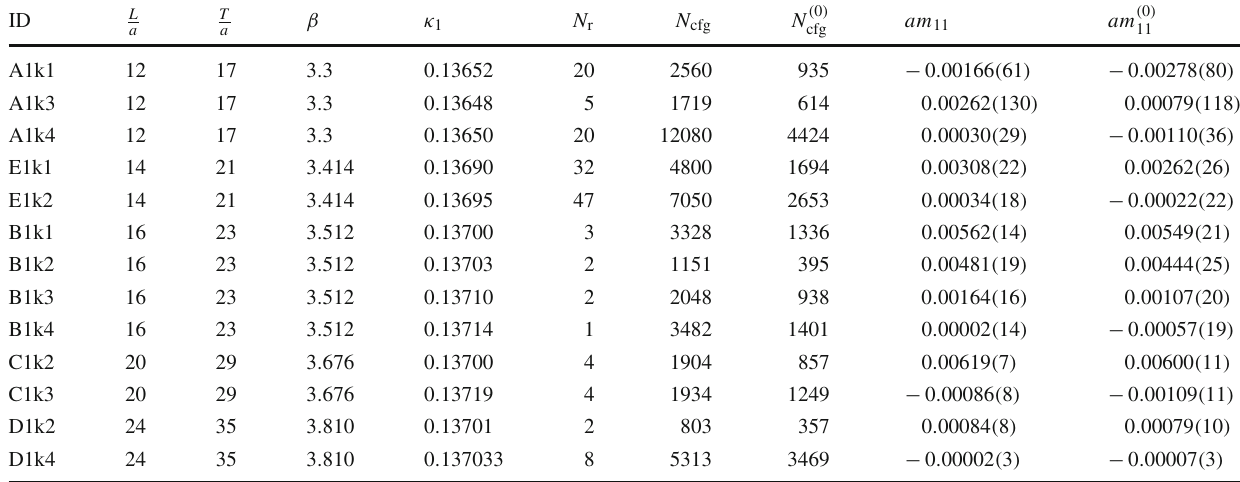
the corresponding PCAC sea quark masses. All ensembles have con- figurations separated by 8 molecular dynamic units (MDU), except for , A1k3 and D1k4 that have 4 and 16 MDU, respectively. Compared to 0 the data base of [17,18], we have generated and used the nearly ( 0 ) ), and cfg